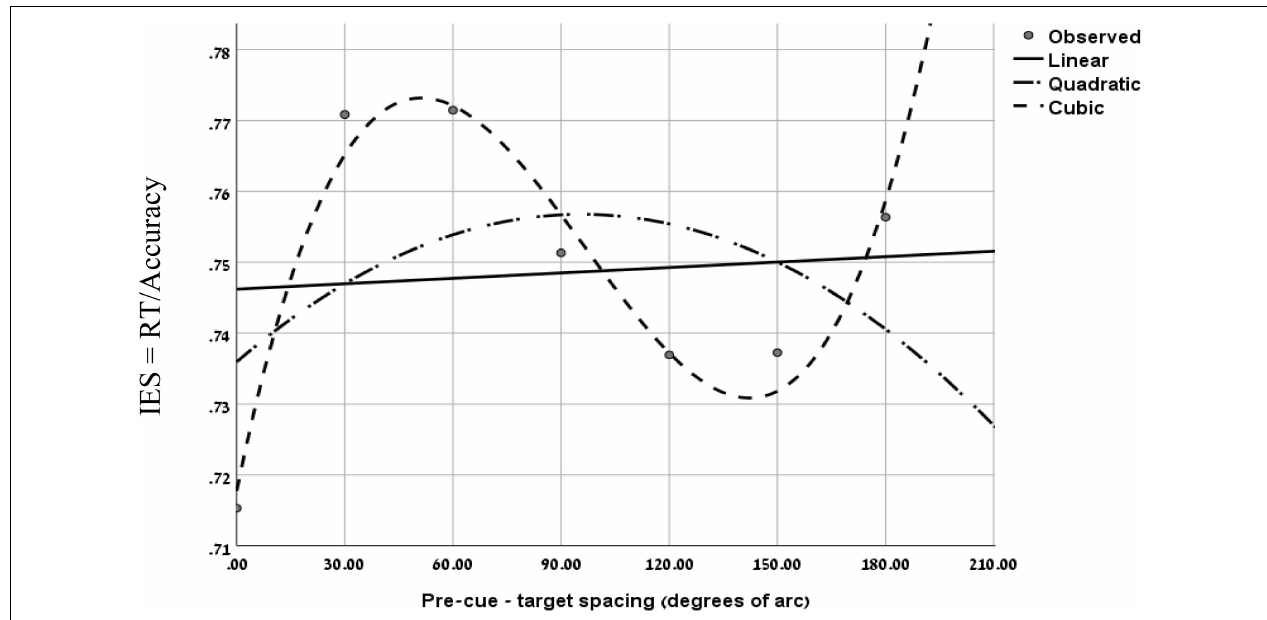
FIGURE 4 | Curve fitting regression on the combined IES data of experiment 1 at SOA = 133 ms and Experiment 2 at SOA = 83 ms, as a function of pre-cue – target spacing.